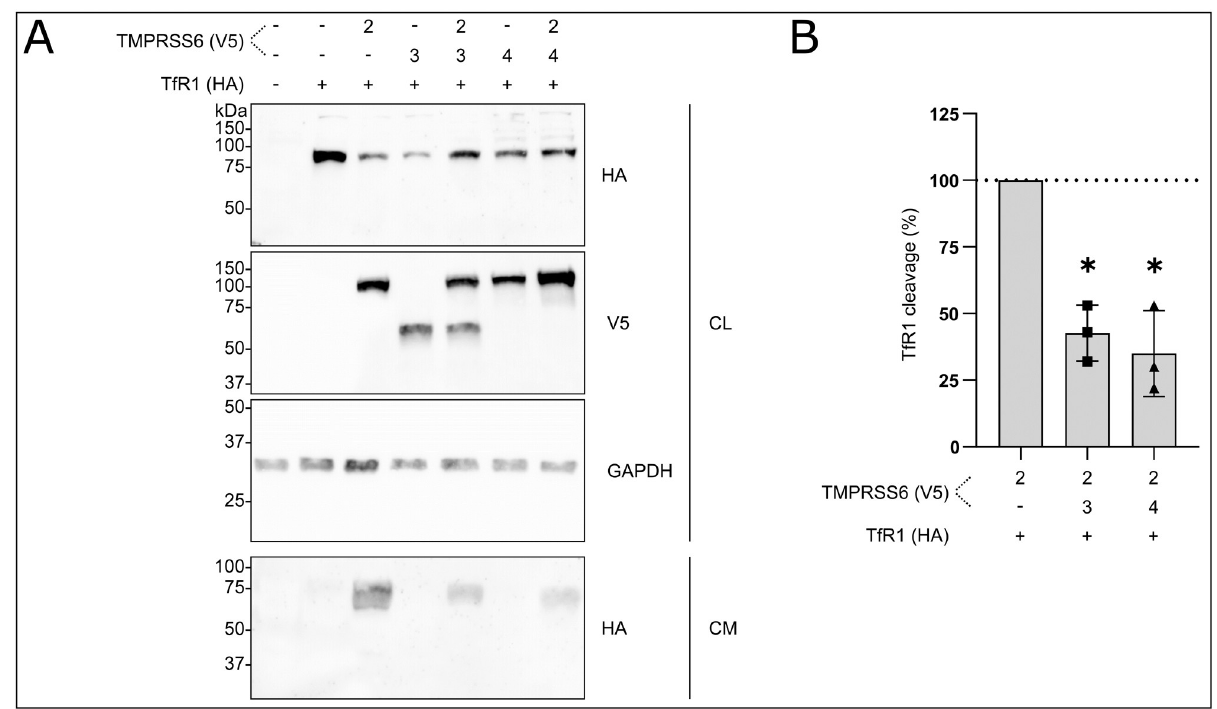
Fig 4. TMPRSS6 cleaves TfR1. A) TfR1-HA was transfected with one or two TMPRSS6-V5 tagged isoforms. Expression was detected in the cell lysate (CL) and cell media (CM) (n = 3). B) TfR1 cleavage quantification. Results are presented as TFR1 cleavage (%) relative to TFR1 cleavage by TMPRSS6 isoform 2. Statistical significance was assessed using one sample T test, � p < 0.02. The means ± SD are presented (n = 3).